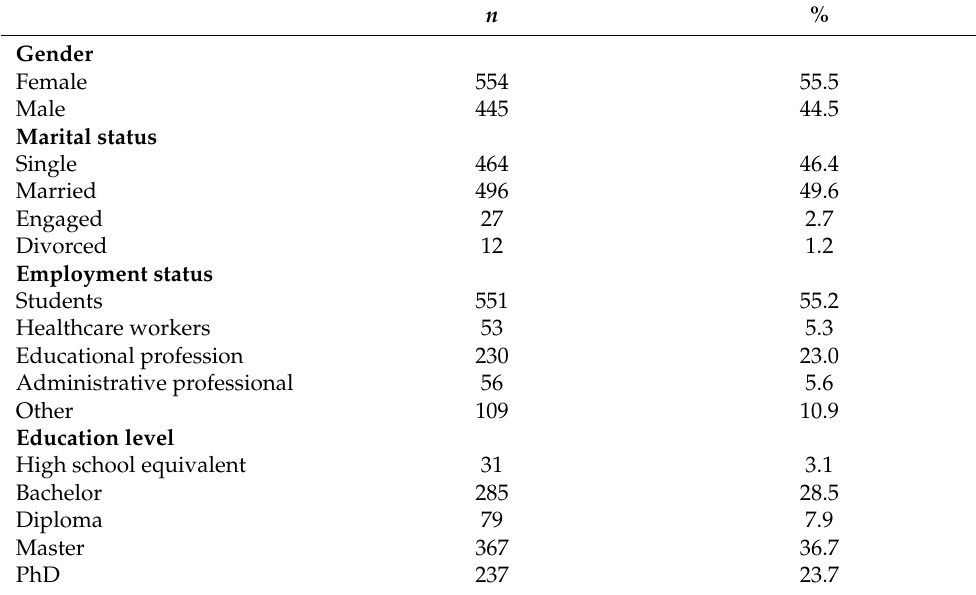
Table 2. Socio-demographic profile of the